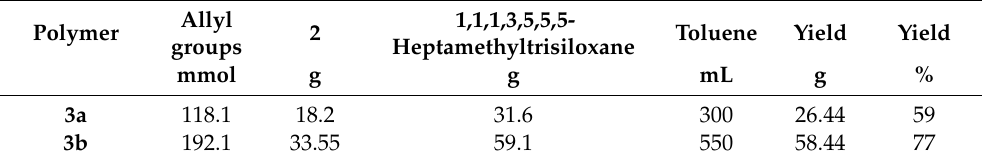
Table 3. Amounts of reagents used for the reaction of hydrosililation of 2 and the reaction yields. Allyl Polymer